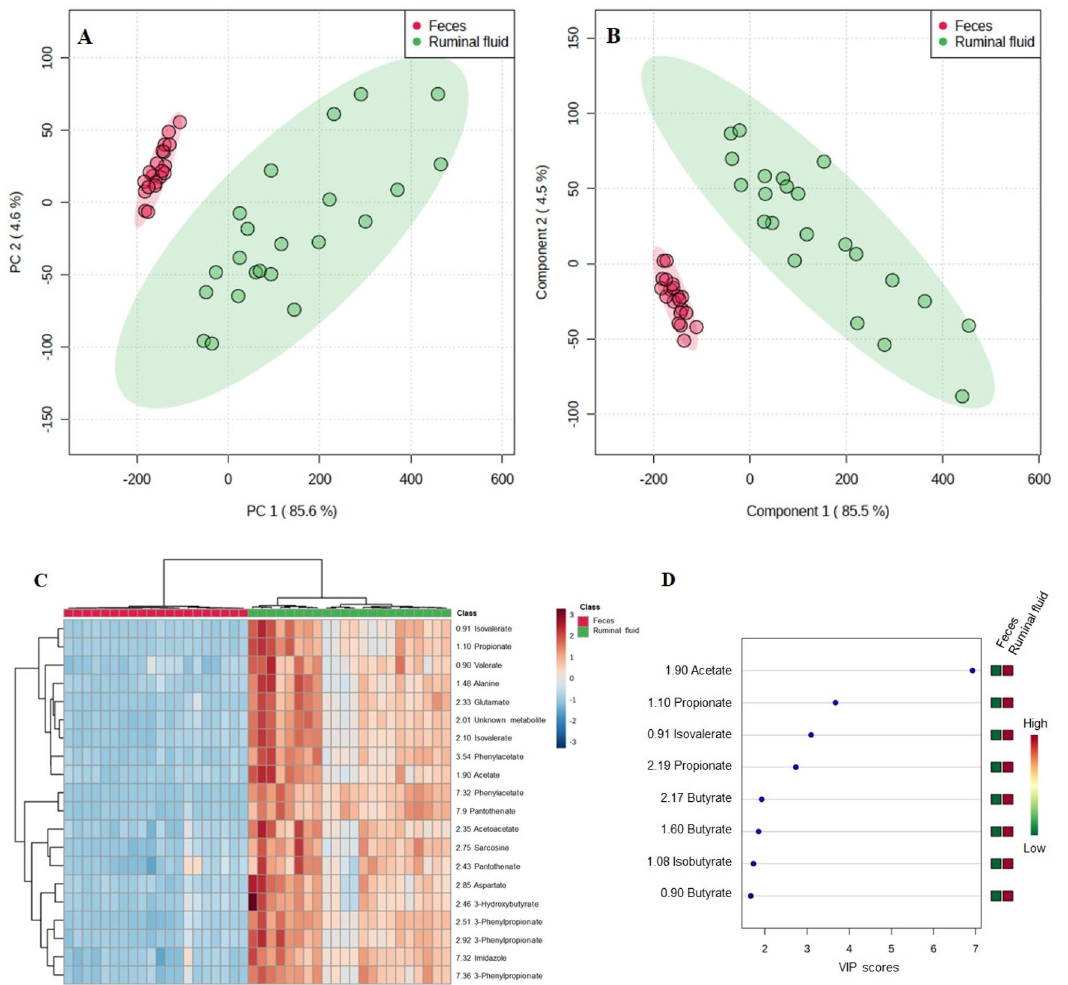
Figure 2. Ruminal fluid and feces metabolomic profile of the Nelore steers. ( A ) Principal component analysis for metabolites identified by 1 H NMR (One data point represents one steer). ( B ) Partial least square- discriminant analysis for 1 H NMR spectrum metabolites identified (One data point represents one steer). ( C ) Hierarchical clustering analysis (heatmap) of metabolomic differences between ruminal fluid and feces by T-test/ANOVA (chemical spectrum shift—ppm). ( D ) Top 5 metabolites (chemical spectrum shift—ppm) selected by VIP score (VIP >